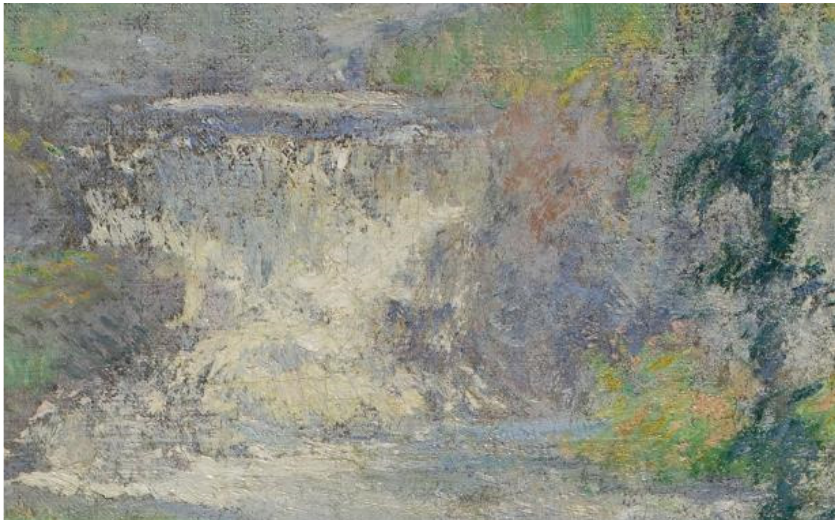
Figure 3. John Henry Twachtman, The Rainbow’s Source [detail], Saint Louis Art Museum, museum’s purchase, 124:1921.